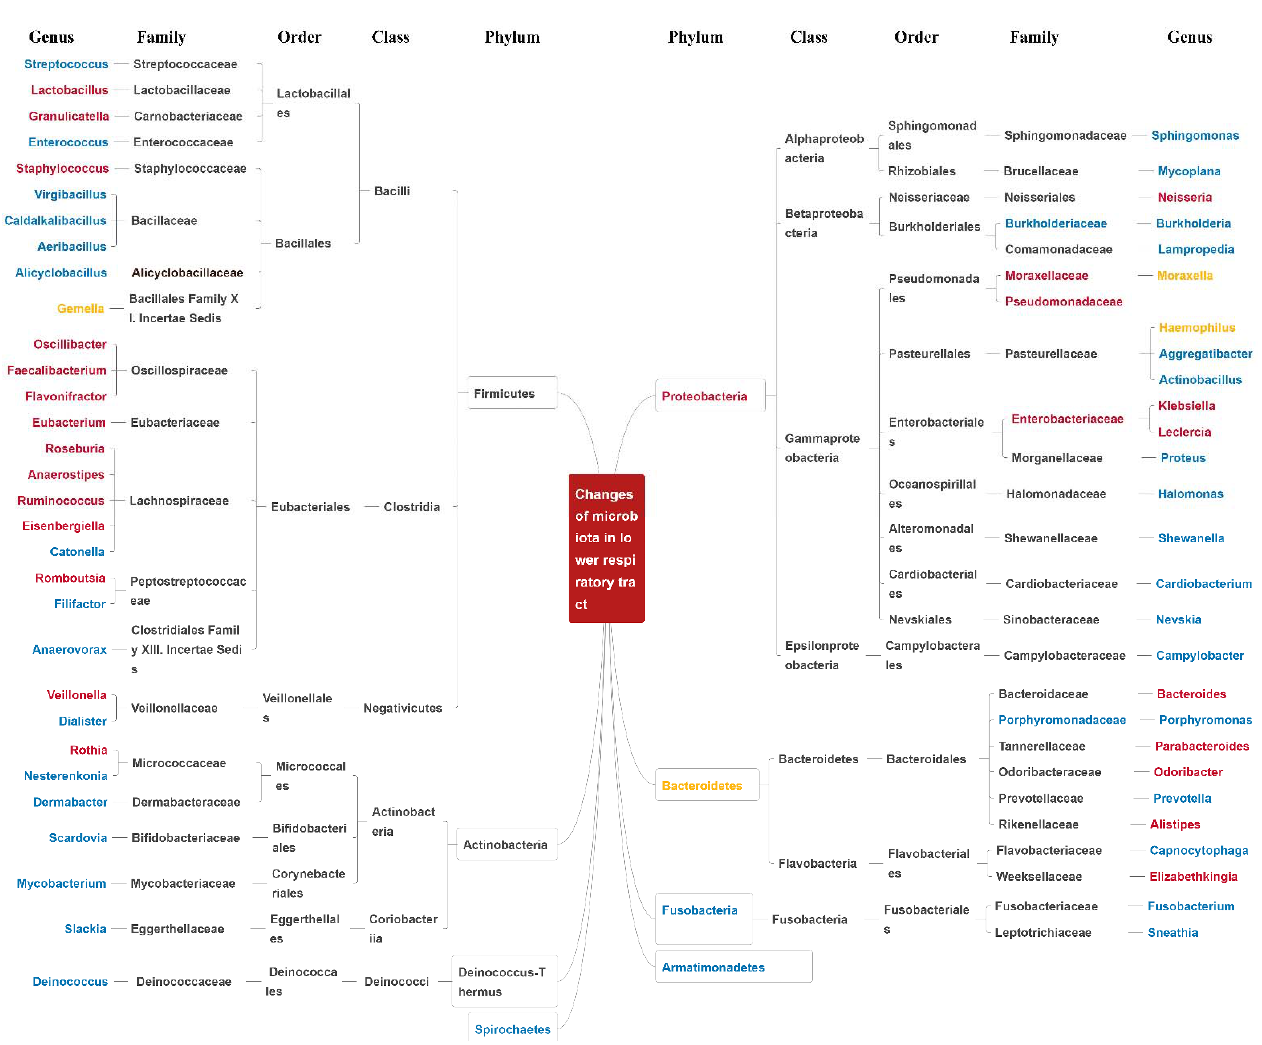
Figure 2. Changes in the bacteria of the lower respiratory tract in asthma. Red represents increased prevalence, blue represents decreased prevalence, and yellow represents uncertain changes in prevalence.